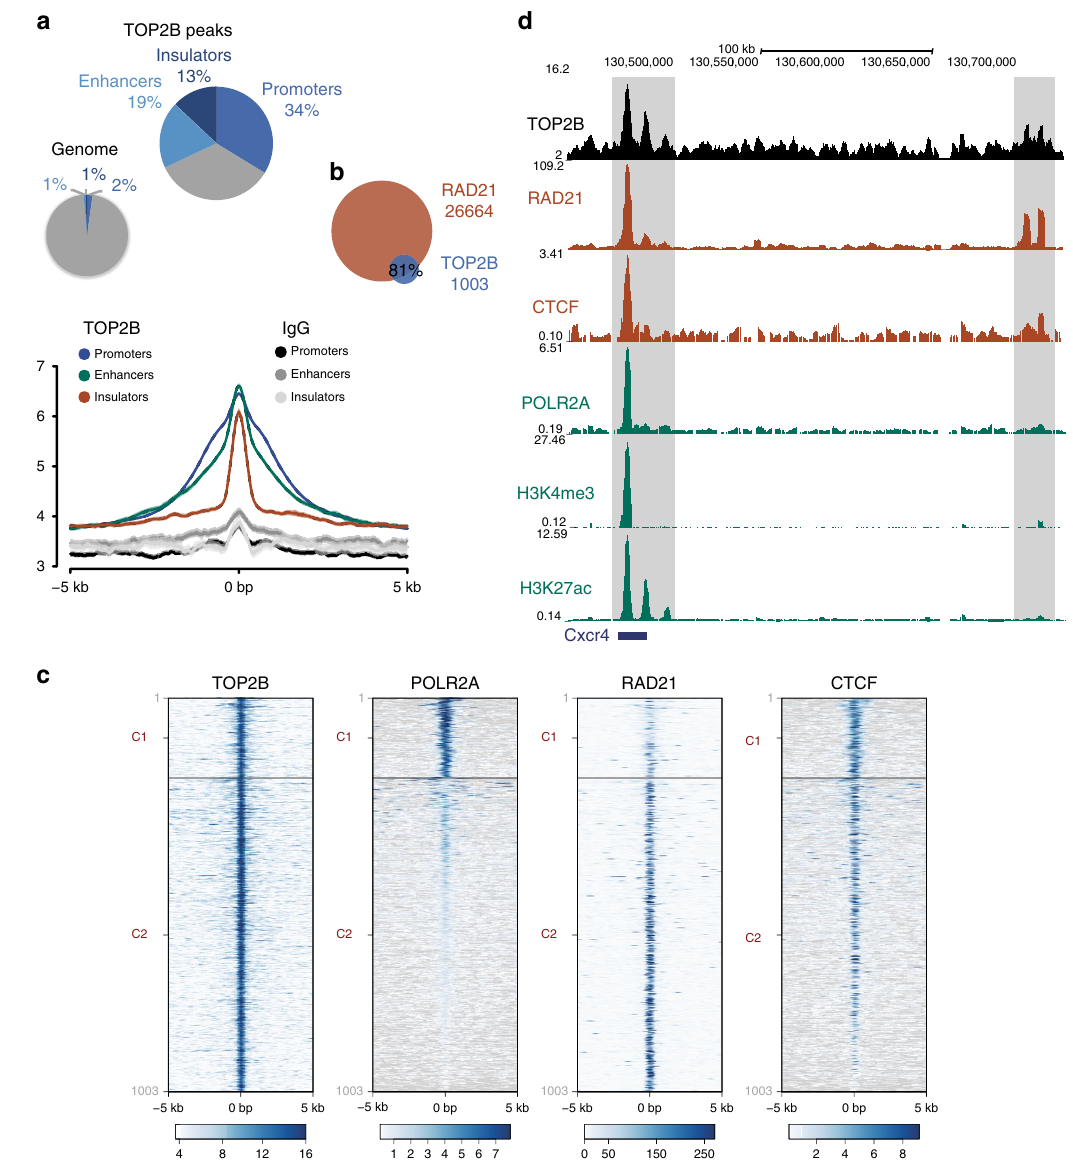
Fig. 4 TOP2B colocalizes with cohesin at promoter, enhancer and insulator regions in thymocytes. a Genome-wide distribution of 1003 TOP2B ChIPseq called peaks at different genomic features (promoters, enhancers, insulators and others) in wild-type primary thymocytes. Chromatin states were de fi ned using ENCODE ccREs registry: H3K4me3, TSS and low H3K27ac for promoters, H3K27ac and low H3K4me3 for enhancers and high CTCF and no presence of the previous histone marks for insulator-like regions.TOP2B peak distribution compared to the entire genome (top), and global signal pro fi le compared to IgG control (bottom) at each genomic feature is shown. TOP2B peaks were de fi ned as common peaks between TOP2B ChIPseq experiments using two different antibodies. b Overlap of TOP2B and RAD21 peaks in wild-type thymocytes. c Genome browser view of TOP2B, RAD21, CTCF, POLR2A, H3K4me3 (ENCODE) and H3K27ac (ENCODE) signal tracks at a representative genomic region encompassing an active promoter (left, positive for POLR2A, H3K4me3 and H3K27ac) and an insulator (right, negative for POLR2A, H3K4me3 and H3K27ac, and positive for CTCF and RAD21). Sites highlighted in grey show sites of major TOP2B signal accumulation over the region. d Heatmaps of TOP2B (this study), POLR2A (ENCODE), RAD21 47 and CTCF (ENCODE) ChIPseq signals at TOP2B peaks (± 5 kb). K-means clusters based on the different signals represented are shown divided by black lines and named as C1 and